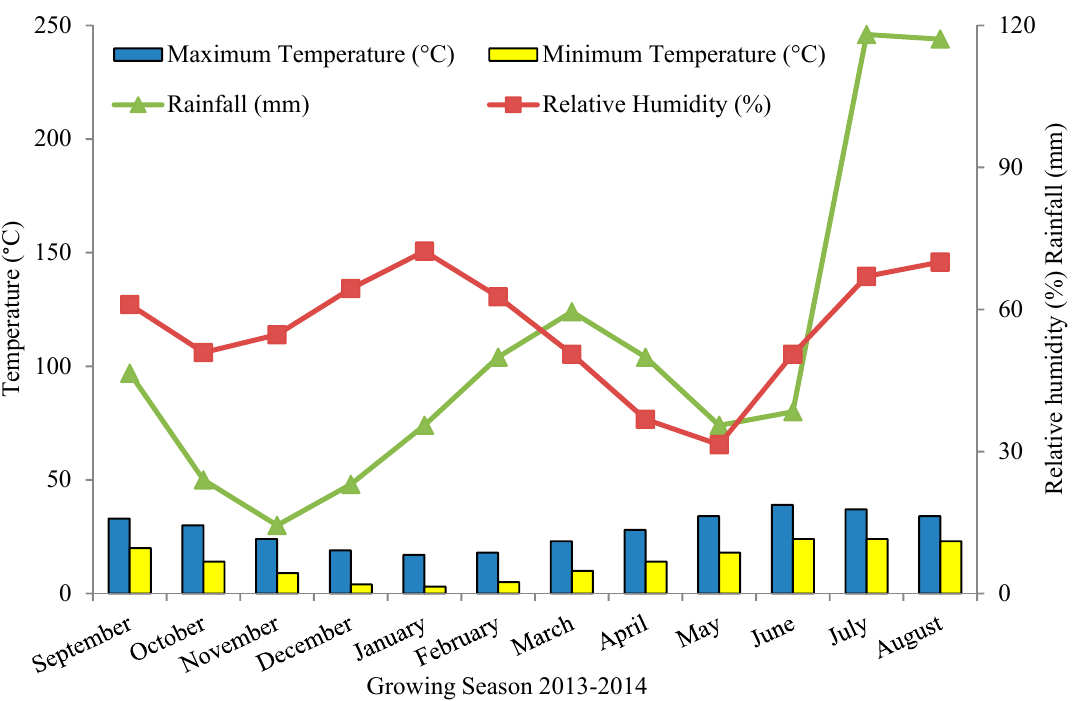
Figure 1. Meteorological data regarding average minimum and maximum temperatures (°C), monthly rainfall (mm) and relative humidity (%) of 2013–2014.